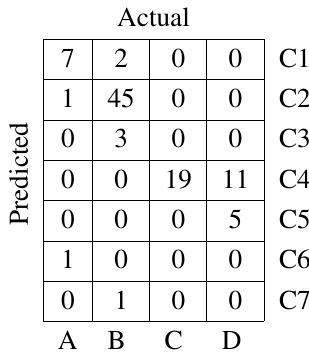
Figure 5. Confusion matrix for MFD and ESOM-based